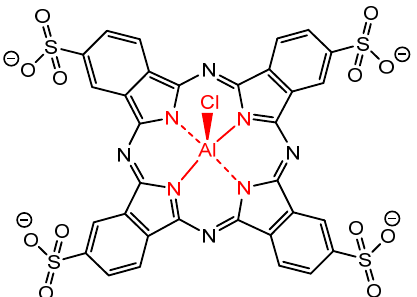
Figure 12. Molecular structure of the tetra-anionic aluminum phthalocyanine presenting good antiparasitic activity against Leishmania major and Leishmania braziliensis , by Pinto et al. [122].